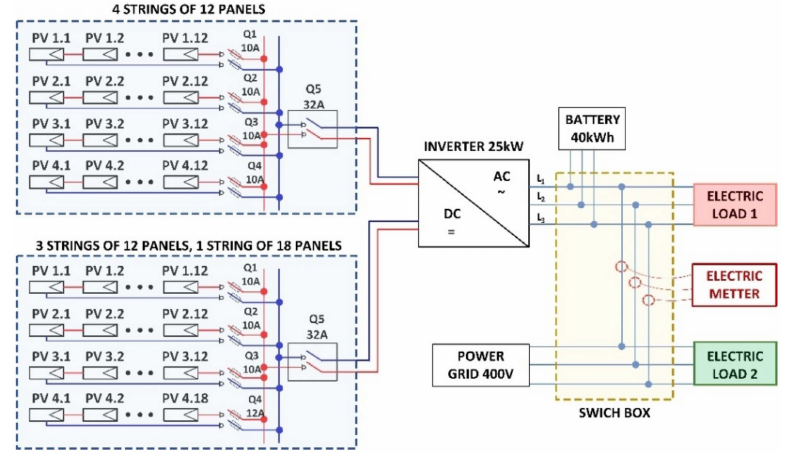
Figure 2. Electric schematic of the CETATEA photovoltaic system.